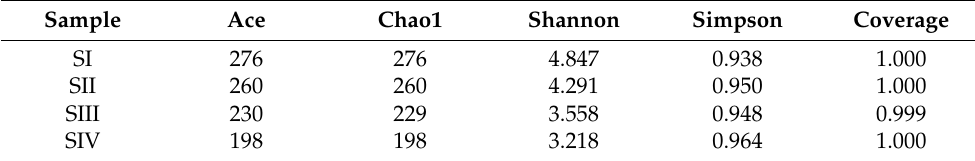
Table 2. Alpha diversity index at the different